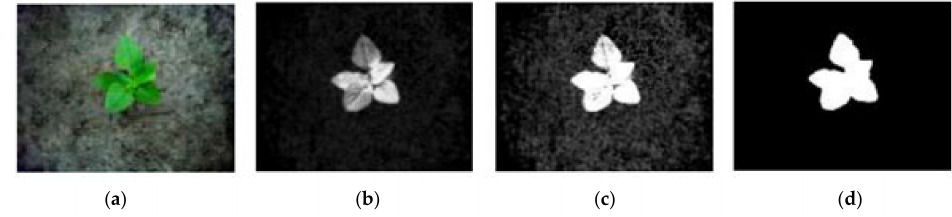
Figure 4. Image processing of pigweed ( A. retroflexus ): ( a ) original image, ( b ) grey-scale image, ( c ) after sharpening, ( d ) with noise filter